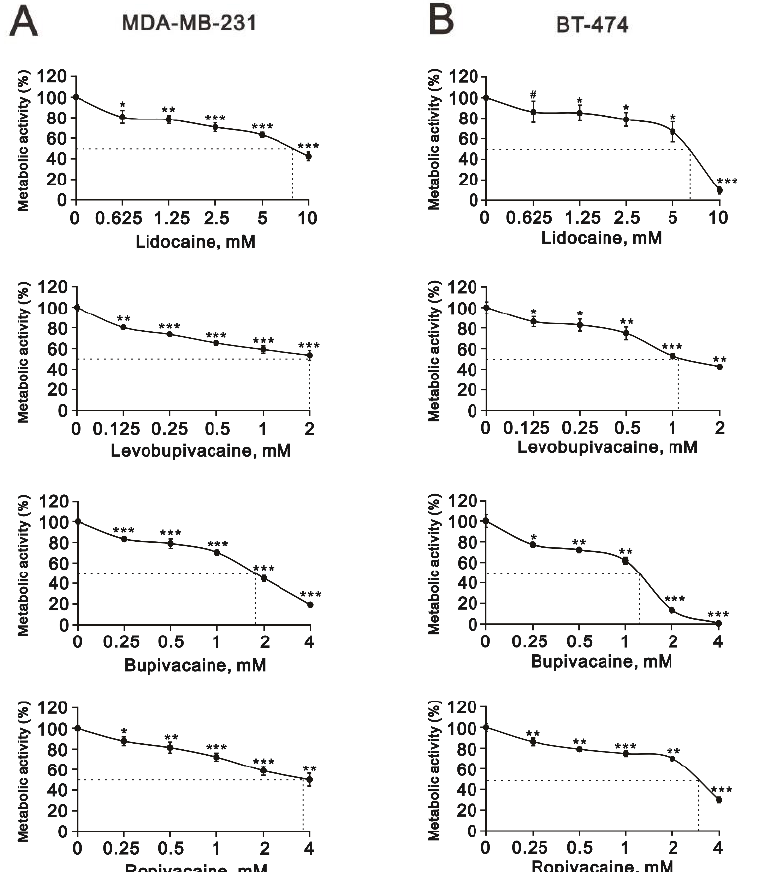
Figure 2. The effects of the local anesthetics on cell viability in MDA-MB-231 and BT474 cells. ( A , B ) MDA-MB-231 and BT-474 (8 × 10 4 ) cells that were treated with the indicated concentrations of lidocaine (0.625, 1.25, 2.5, 5, and 10 mM), levobupivacaine (0.125, 0.25, 0.5, 1, and 2 mM), bupivacaine (0.25, 0.5, 1, 2, and 4 mM), and ropivacaine (0.25, 0.5, 1, 2, and 4 mM) for 24 h. Control cells were cultured under identical conditions. Metabolic activity was measured using an MTT colorimetric assay. Data are presented as a percentage of the control. Bars depict the mean ± SD. # p > 0.05; * p < 0.05; ** p < 0.01; *** p < 0.001.